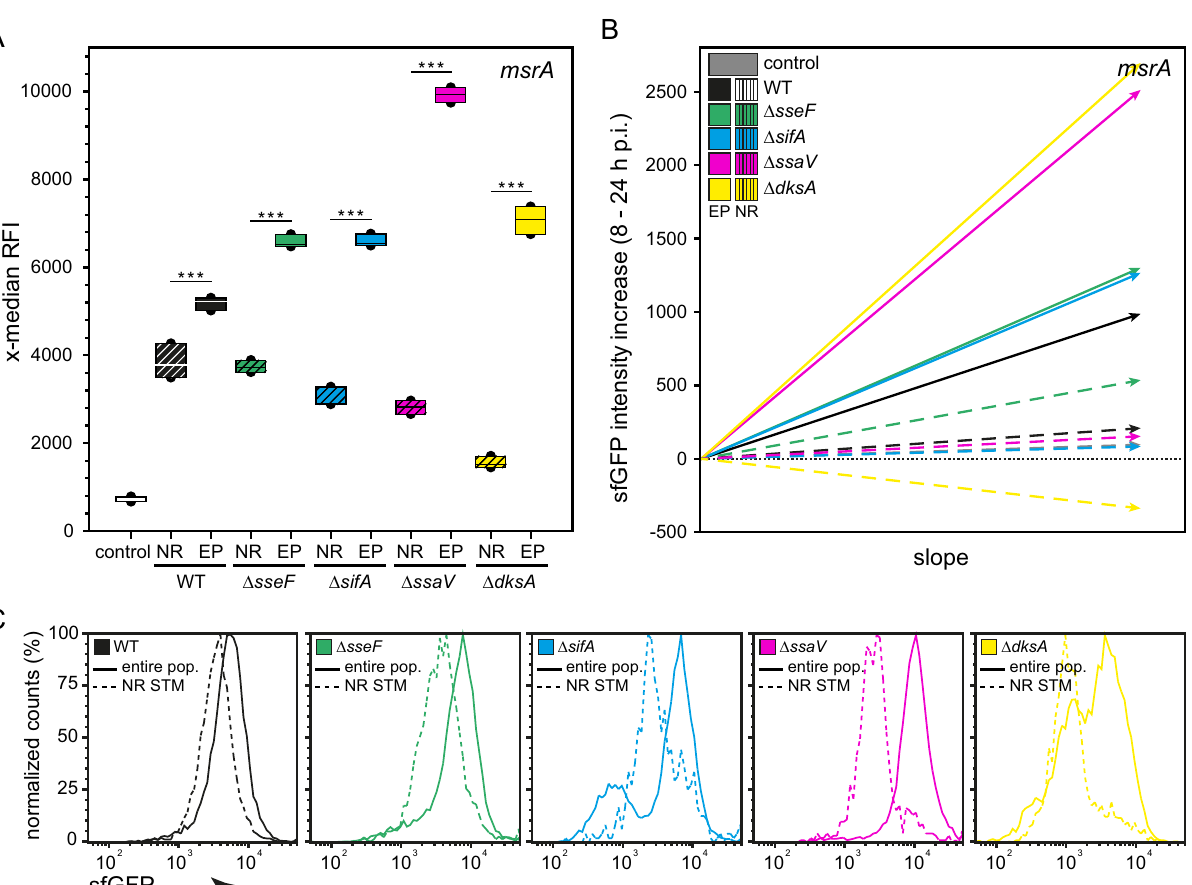
Fig. 3 Non-replicating SPI2-T3SS or SR mutant strains also show lower stress response compared to respective subpopulation. STM WT, Δ sseF , Δ sifA , Δ ssaV , and Δ dksA strains harboring AHT-inducible (NR), or constitutive (entire population, EP) dual- fl uorescence reporter for msrA were grown o/n in LB medium. AHT was present for AHT-inducible reporters and removed before infection. RAW264.7 macrophages were infected, lysed 24 h p.i., liberated STM were recovered, fi xed, and subjected to FC analyses. As negative control, a dual FP reporter plasmid with sfgfp inactivated by a frameshift was used. A The x-median represents the msrA -induced sfGFP signal of the DsRed-positive intracellular bacterial population at 24 h p.i. Means and standard deviations of one representative experiment are shown. Statistical analysis was performed as described for Fig. 2 and is indicated for NR vs. EP for each strain. B The depicted slopes represent the sfGFP intensity increase over the time of infection. C Representative histograms corresponding to A are